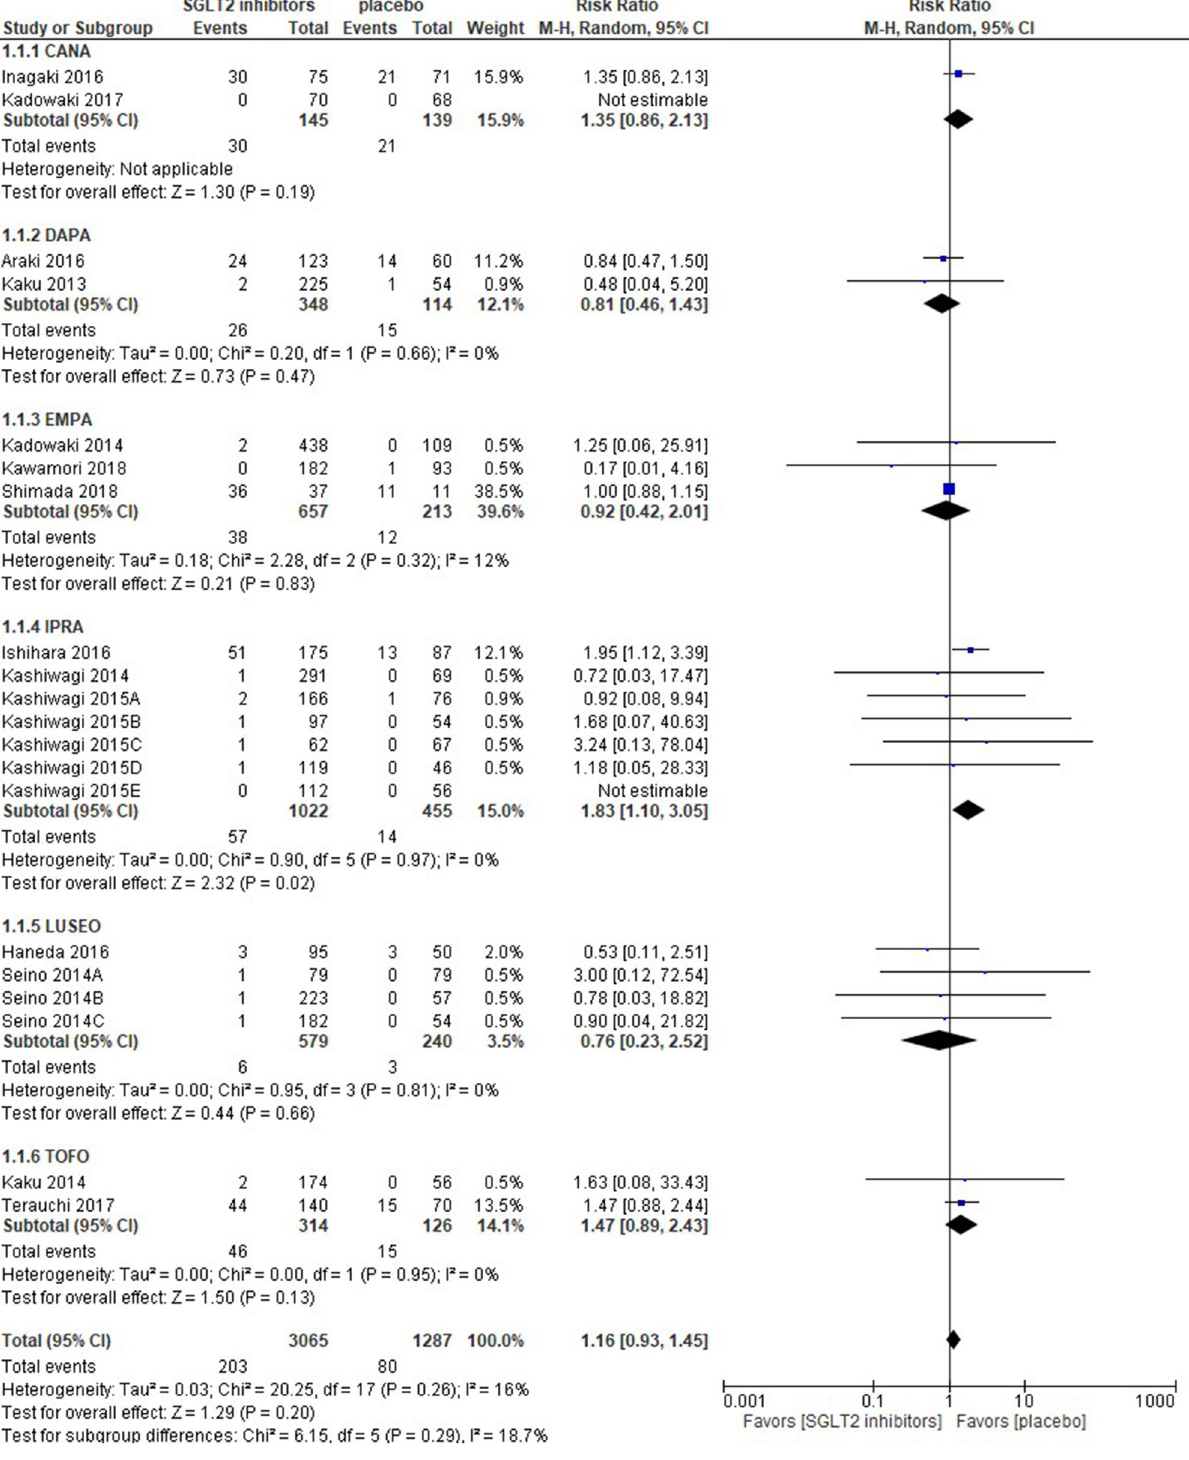
Figure 1. Forest plot for the risk of hypoglycemia. CANA canagliflozin, DAPA dapagliflozin, EMPA empagliflozin, IPRA ipragliflozin, LUSEO luseogliflozin, TOFO tofogliflozin, SGLT2 sodium-glucose co-transporter